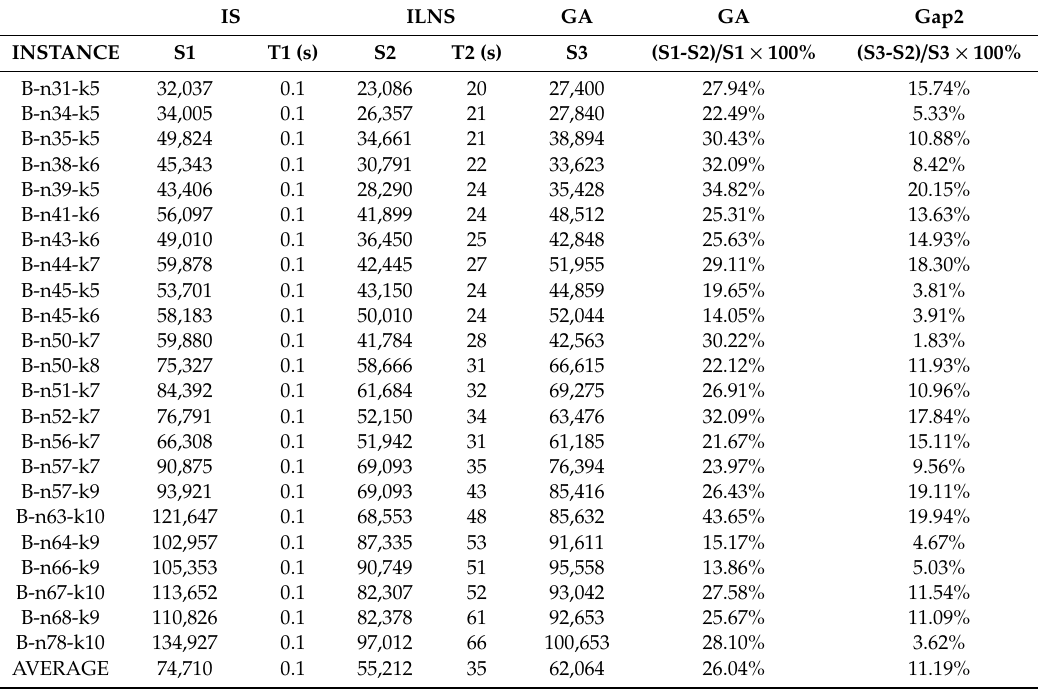
Table 3. Computational results of four algorithms for Group